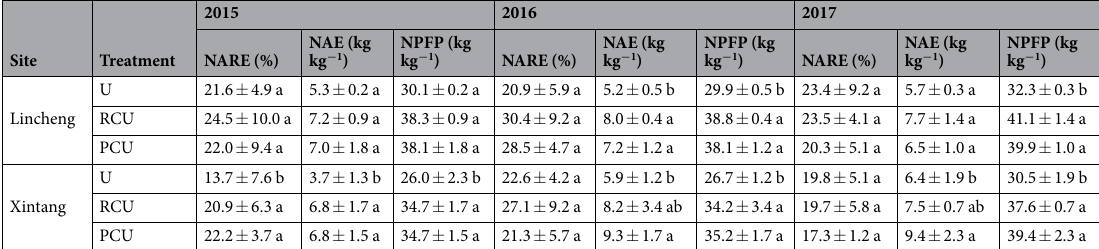
Table 4. Indices of N use efficiency were affected by the different treatments at the two experimental sites during the 2015 to 2017 rice growing seasons. The values are presented as the mean ± standard deviation (n = 3). Different letters in the same columns at the same site represent significant differences at the level of P < 0.05. U, RCU and PCU represent conventional urea, resin-coated urea and polyurethane-coated urea, respectively. NARE, NAE and NPFP represent N apparent recovery efficiency, N agronomic efficiency and N partial factor productivity,